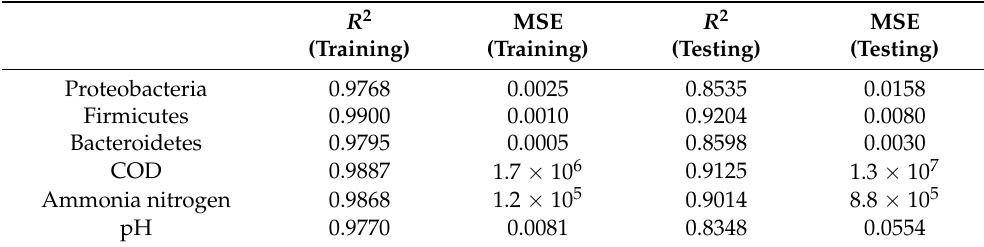
Table 7. Comparison of the RF prediction models based on PCA.